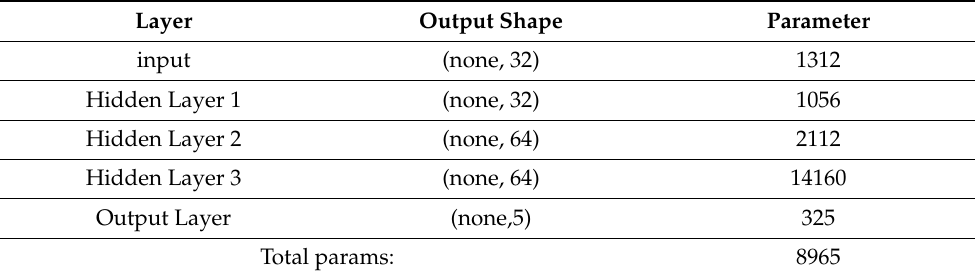
Figure 6. MLP model accuracy curve with epoch = 200. Table 4. The hyper-parameter of